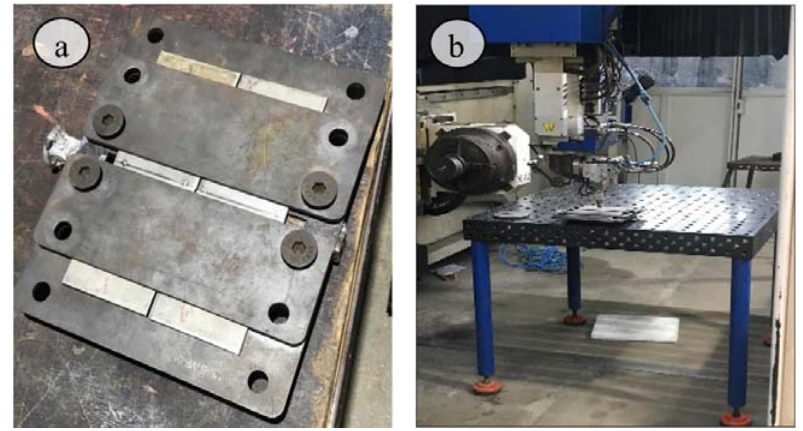
Figure 2. ( a ) Clamping conditions; ( b ) CO 2 laser beam welding machine.